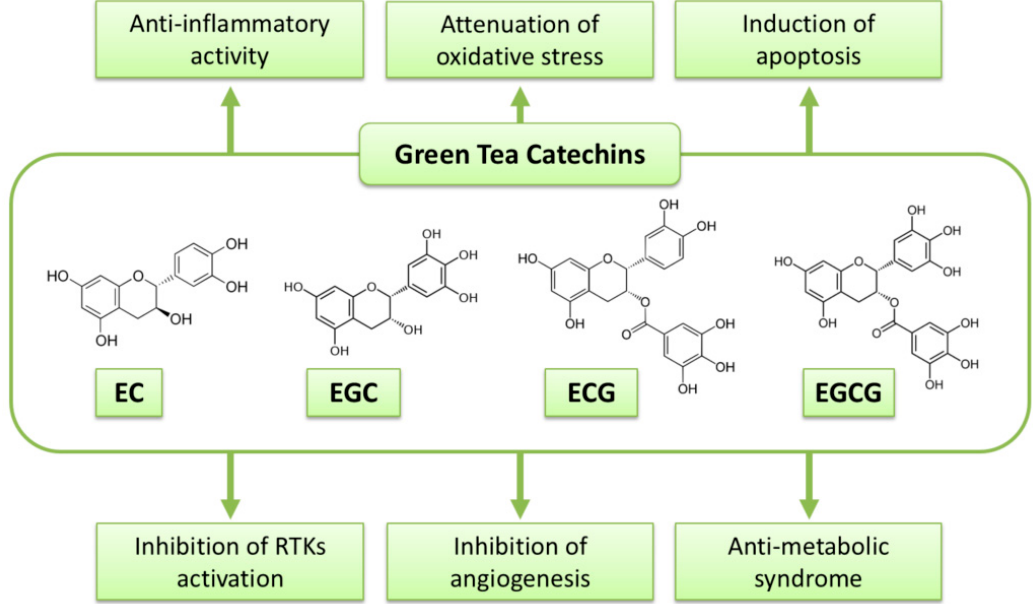
Figure 1. Possible mechanisms of green tea catechins against cancer.